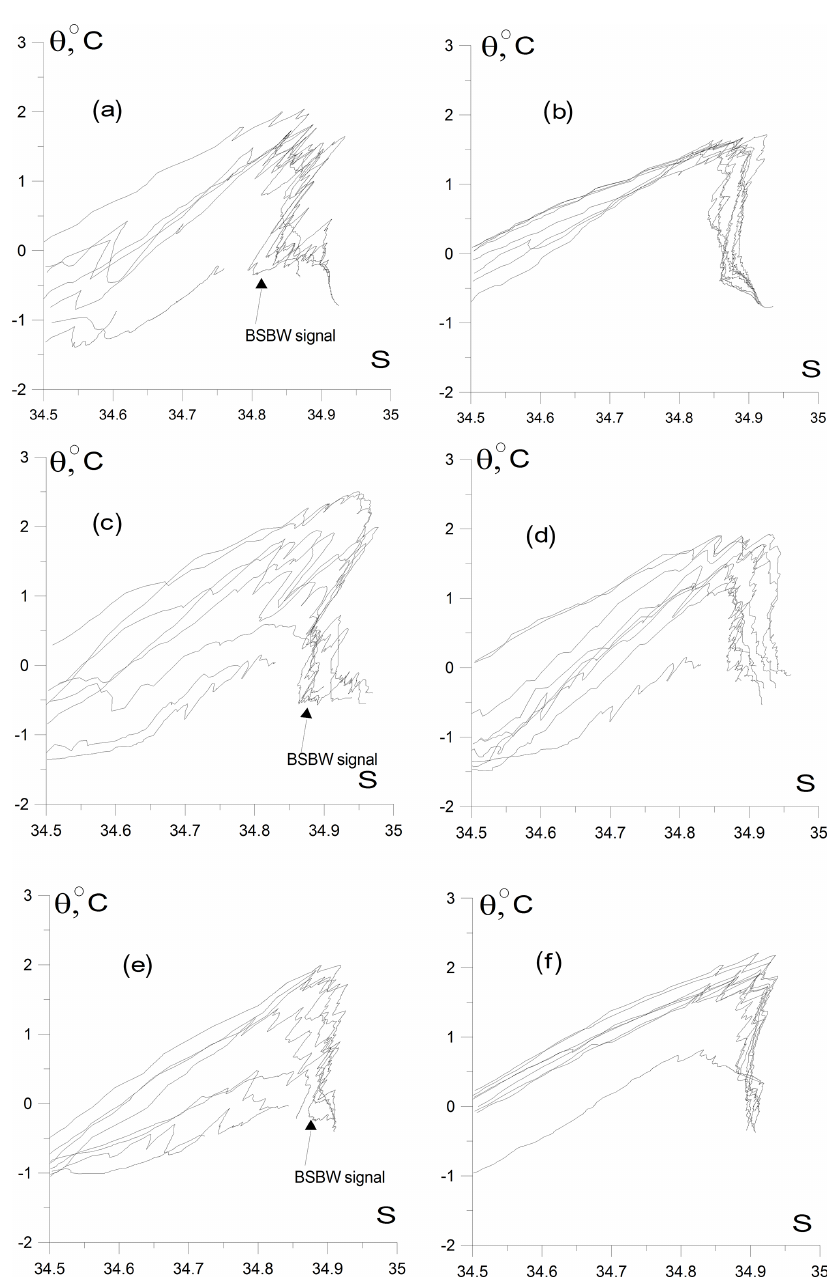
Figure 9. θ – S diagrams based on the CTD profiling: NABOS05 – ( a, b ), 103 ◦ E (a) , 126 ◦ E (b) ; NABOS06 – ( c, d ), 103 ◦ E (c) , 126 ◦ E (d) ; NABOS08 – ( e, f ), 103 ◦ E (e) , 126 ◦ E (f)